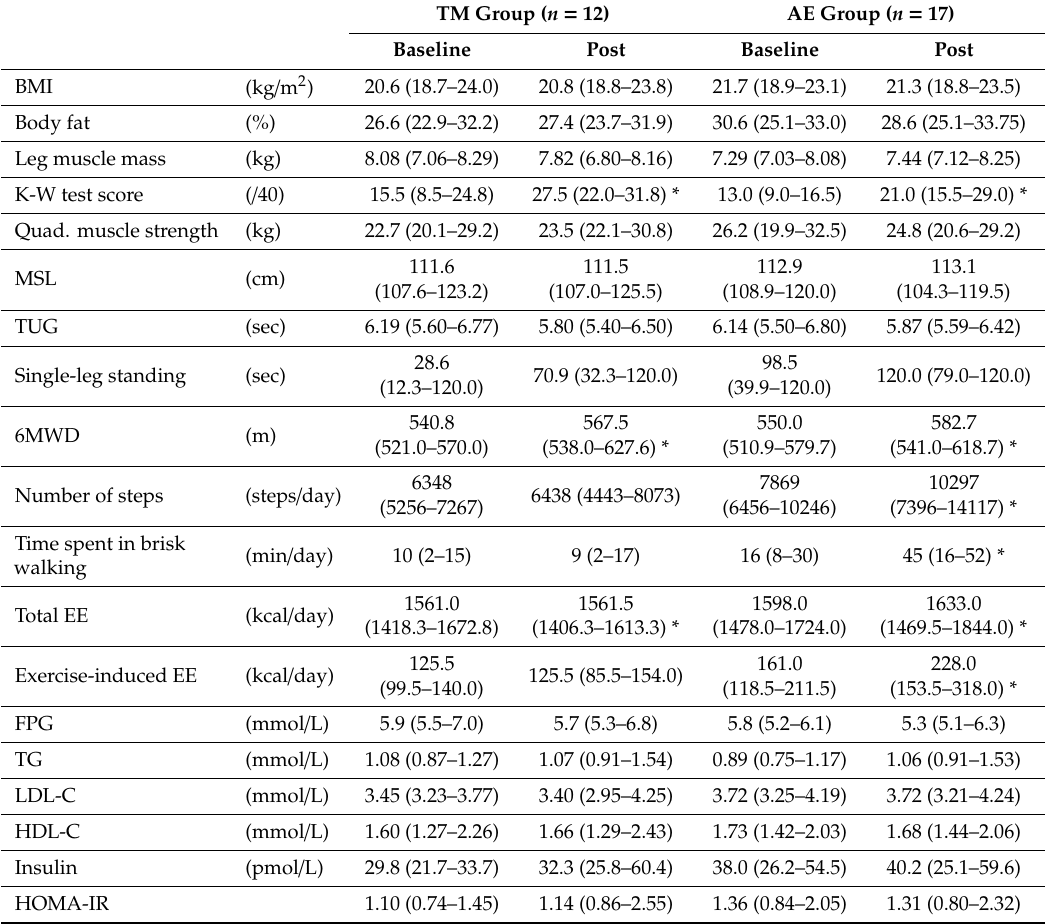
Table 2. Changes in the parameters following the